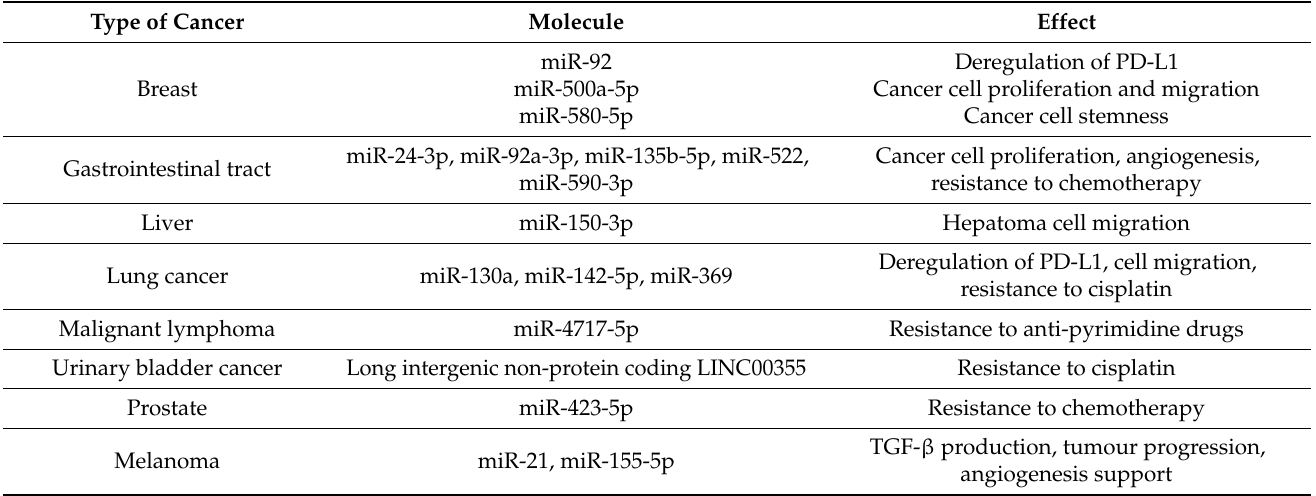
Table 4. Effect of CAF-derived exosomes on cancer (selected